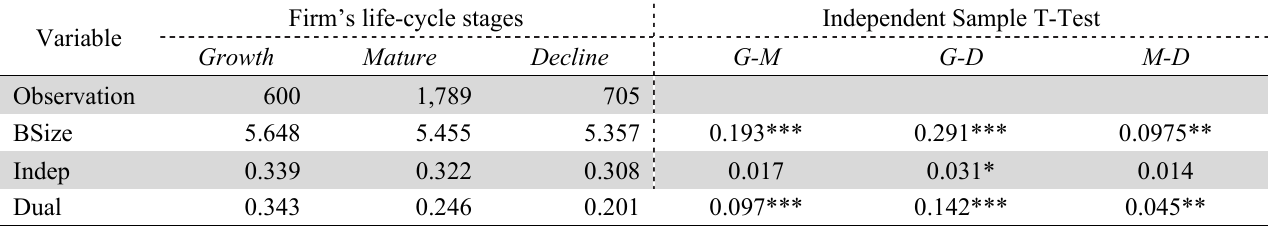
Mean difference tests for board composition variables by firm’s life-cycle stages.